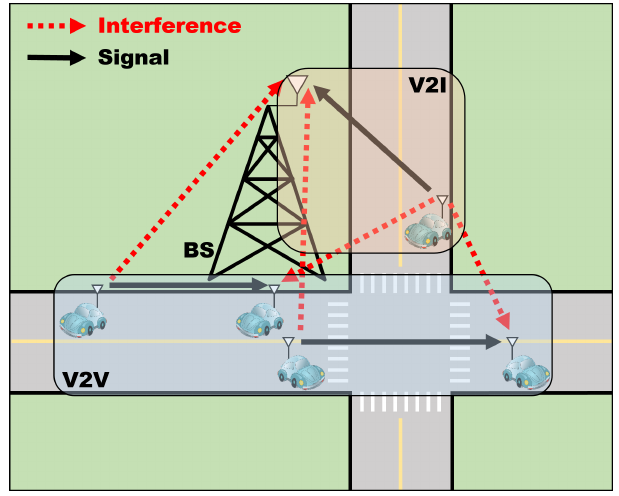
Figure 1. A system